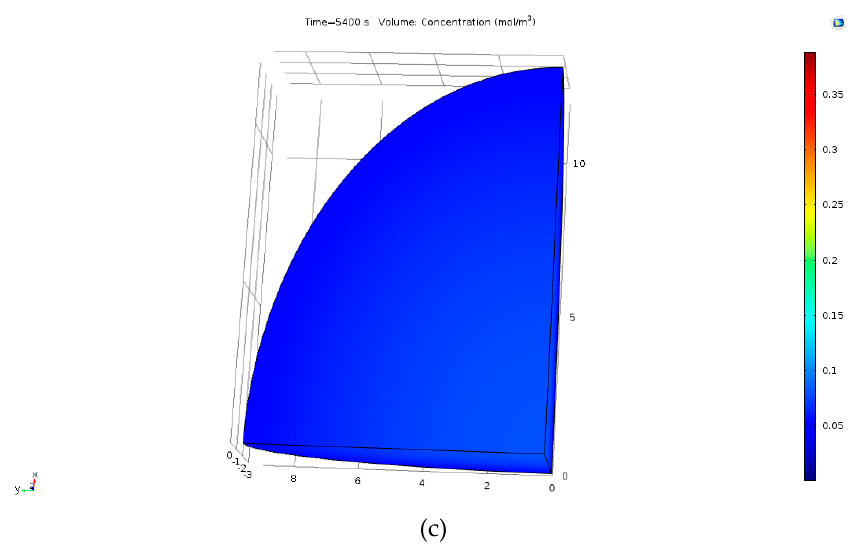
Figure 4. Concentration at various points along a cross-section from the surface to the center of the component of the stevia solid matrix at different time points: ( a ) t = 30 min, concentration value = 0.19998–0.38777 mol/m 3 ; ( b ) t = 60 min, concentration value = 0.10004–0.15184 mol/m 3 ; ( c ) t = 90 min, concentration value = 0.049976–0.079217 mol/m 3 .